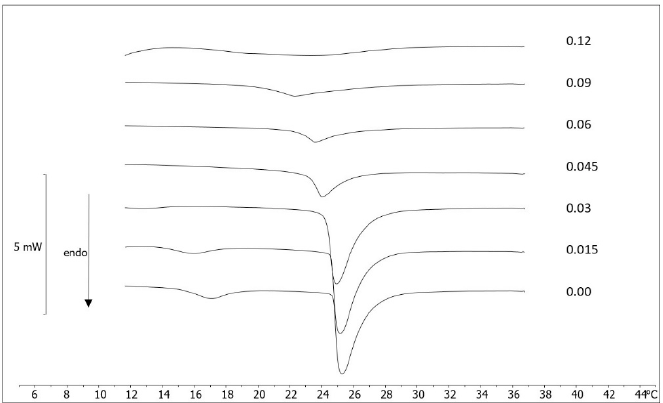
Figure 3. Calorimetric curves, in heating mode, of MLV prepared without and with BXL at different molar fractions.